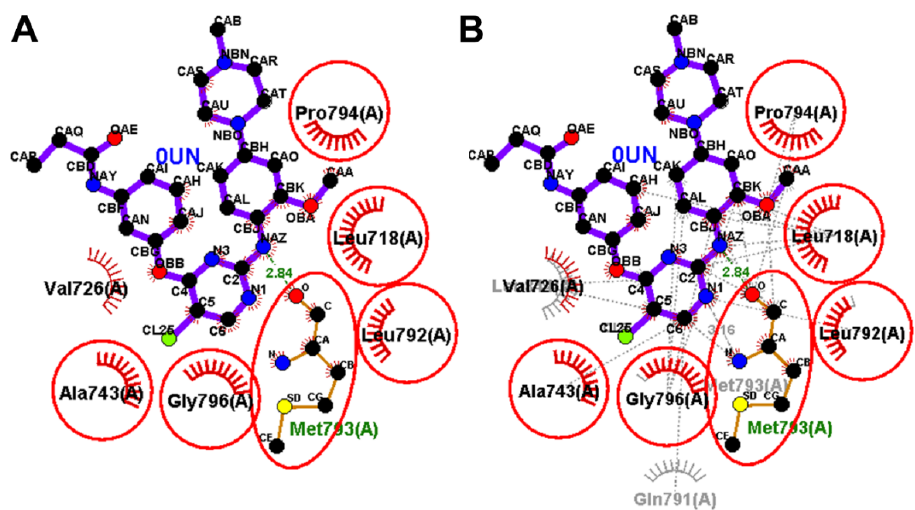
Figure 16. Binding interactions of the redocked WZ4003 (shown as purple sticks) into EGFR T790M (pdb: 5X2K): ( A ) redocked WZ4003; ( B ) superposed LigPlot view of the redocked WZ4003 (purple sticks) overlaid with the co-crystallized ligand (gray sticks), the red circles/ellipses show the equivalent binding interactions of the two molecules, hydrogen bond is shown in olive green dotted lines (Met793), and hydrophobic interactions are shown in brick red dotted lines. Olmutinib was also docked into the crystal structure of EGFR T790M (PDB: 5X2K) to identify the potential binding mode and interactions. The results of the docking study of olmutinib revealed a binding free energy of − 8.40 kcal/mol compared to WZ4003 ( − 8.07 kcal/mol). The top ten scoring conformations of olmutinib were analyzed and their bind- ing modes and interactions were compared with those of the co-crystallized WZ4003. The results also revealed that the sixth-ranked pose superposed with WZ4003 and formed two hydrogen bonds with Met793 and Cyc797, Figure 17. Figure 17. Binding mode/interactions of olmutinib (shown as sticks colored by element) into EGFR 696-1022 T790M (pdb: 5X2K): ( A ) 3D binding mode of olmutinib overlaid with the co-crystallized ligand, WZ4003 (yellow sticks); ( B ) 2D binding mode of olmutinib showing different types of binding interactions. The binding interactions of olmutinib were also visualized by LigPlot+, where two conventional hydrogen bonds with Met793 and Cys797 were present, Figure 18. In addi- tion, a third hydrogen bond between N1 of the pyrimidine ring in olmutinib and Met793 was detected by LigPlot+. This hydrogen bond could account even partially for the higher binding free energy of olmutinib compared to WZ4003. The superposed LigPlot view of olmutinib and WZ4003 revealed two equivalent hydrogen bonds with Met793. The two molecules also exhibited equivalent hydrophobic interactions with Leu718, Ala743, Gln791, Leu792, Gly796, and Leu844.